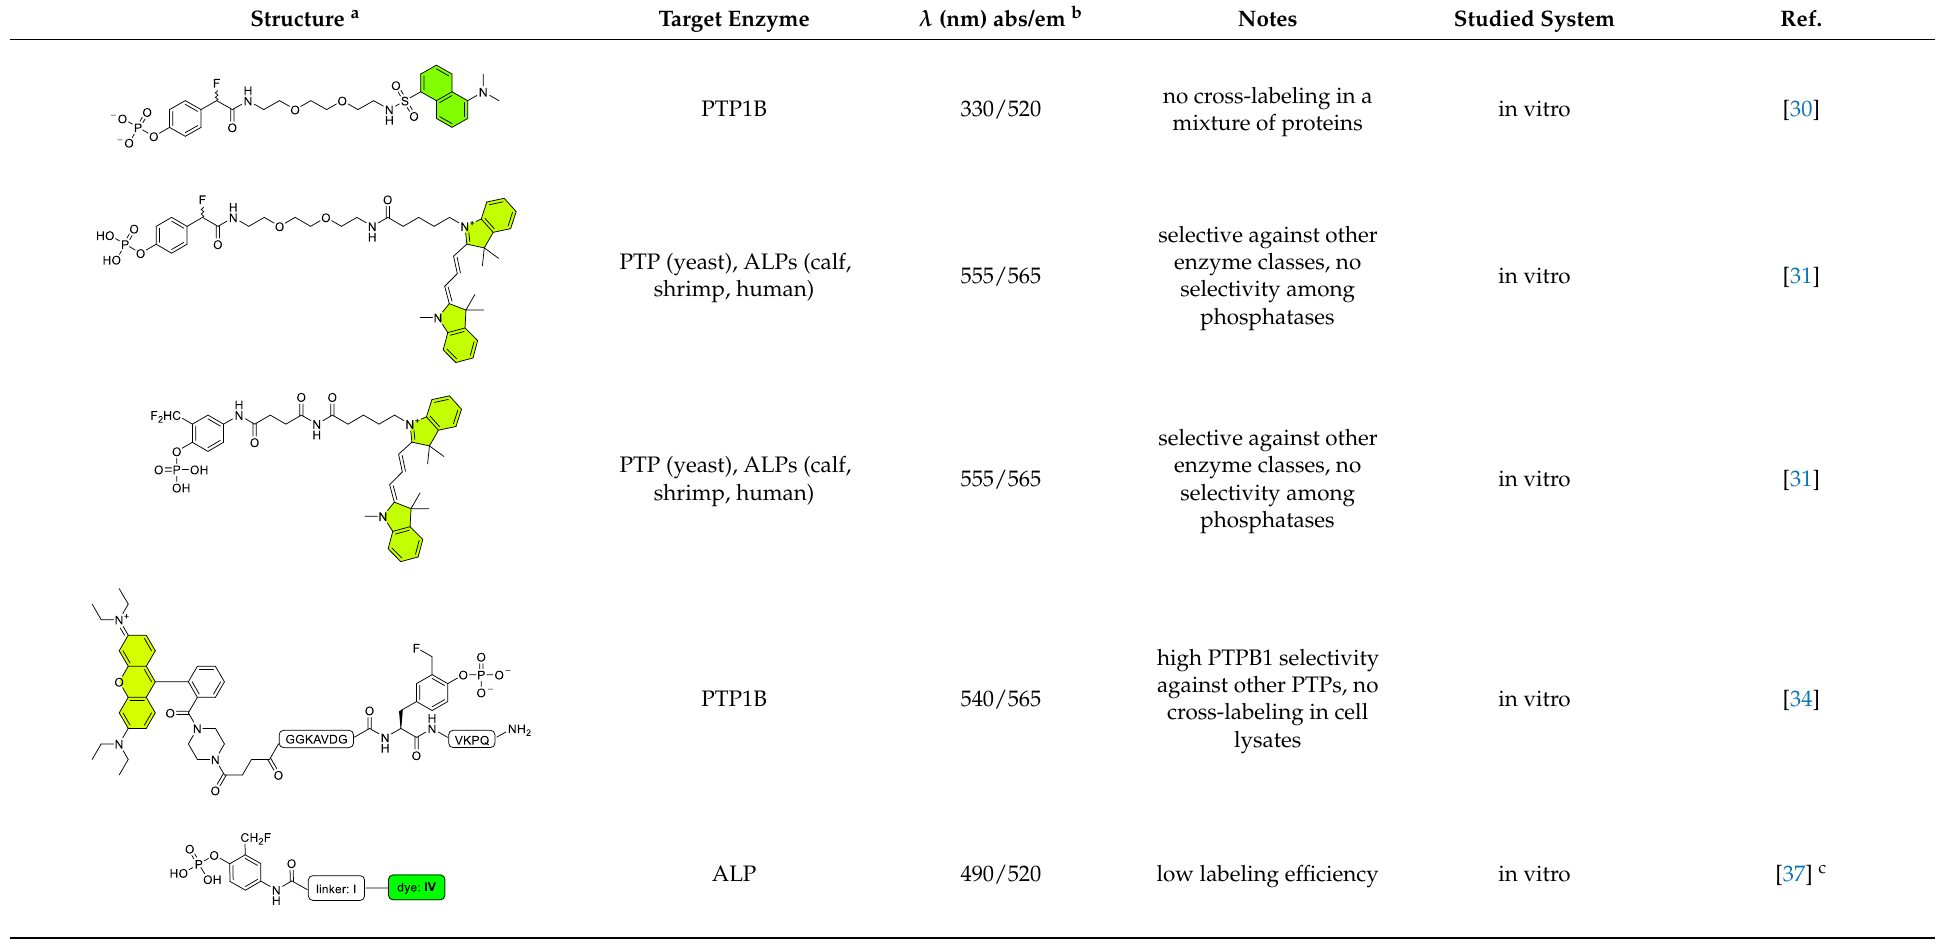
Table 2. Non-fluorogenic activity-based probes for different phosphatases.